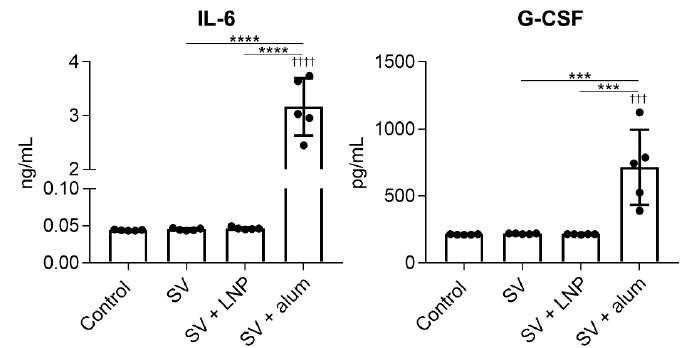
Figure 9. Production of inflammatory cytokines by the LNP and alum in vivo. Mice were treated intraperitoneally with the SV alone, SV plus LNP, or SV plus alum. After 4 h, the concentrations of IL-6 and granulocyte-colony stimulating factor (G-CSF) in peritoneal lavage fluid were measured by using ELISA. n = 5 per group. Data are means ± SD. ††† p < 0.001 and †††† p < 0.0001 vs. untreated control group; *** p < 0.001 and **** p < 0.0001, as indicated by Tukey’s test.